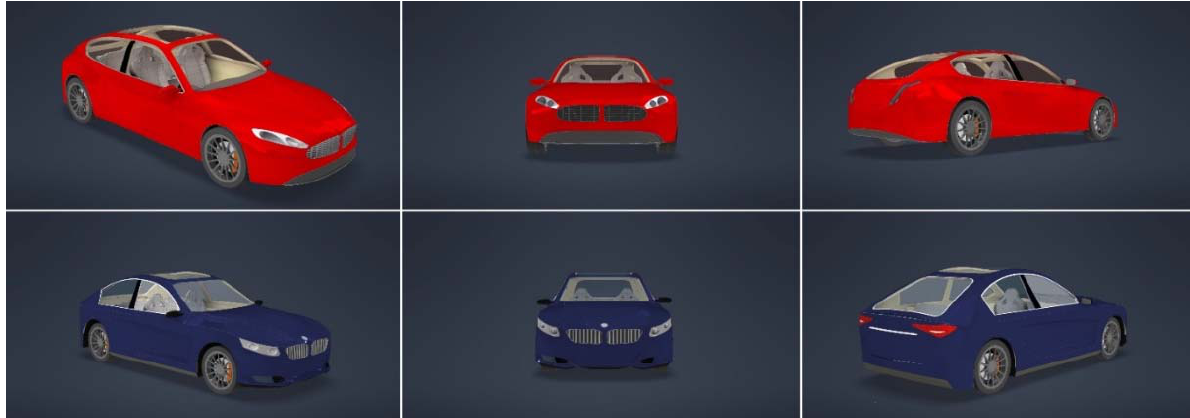
Figure 19. Final CAD models. Above row: Blitz Vision Retro. Lower row: Blitz Vision AS.